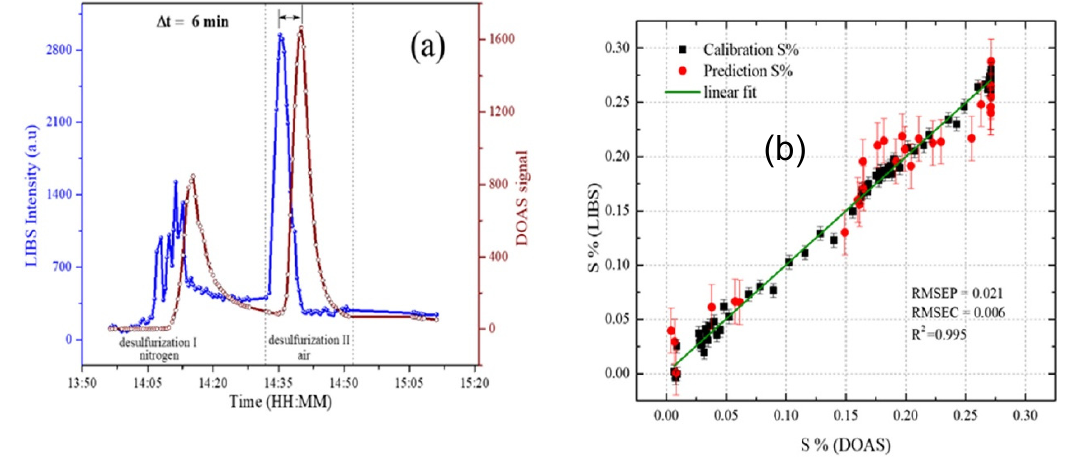
Figure 6. The monitoring results of desulfurization in the pyrometallurgical process of the copper blister by Myakalwar et al. [76]: ( a ) Signal of LIBS (921.29 nm) of sulfur and DOAS signal of SO2 gas during desulfurization of blister copper. ( b ) PLS prediction results of sulfur in molten phase using LIBS using DOAS as gold standard method. (Reprinted from Analytica Chimica Acta, vol. 1178, Myakalwar, A.K., Sandoval, C., Sepúlveda, B., Fuentes, R., Parra, R., Balladares, E., Vásquez, A., Sbarbaro, D., and Yáñez, J., Laser induced breakdown spectroscopy for monitoring the molten phase desulfurization process of blister copper, 338805, 2021). Copyright (2021), with permission from Elsevier.).